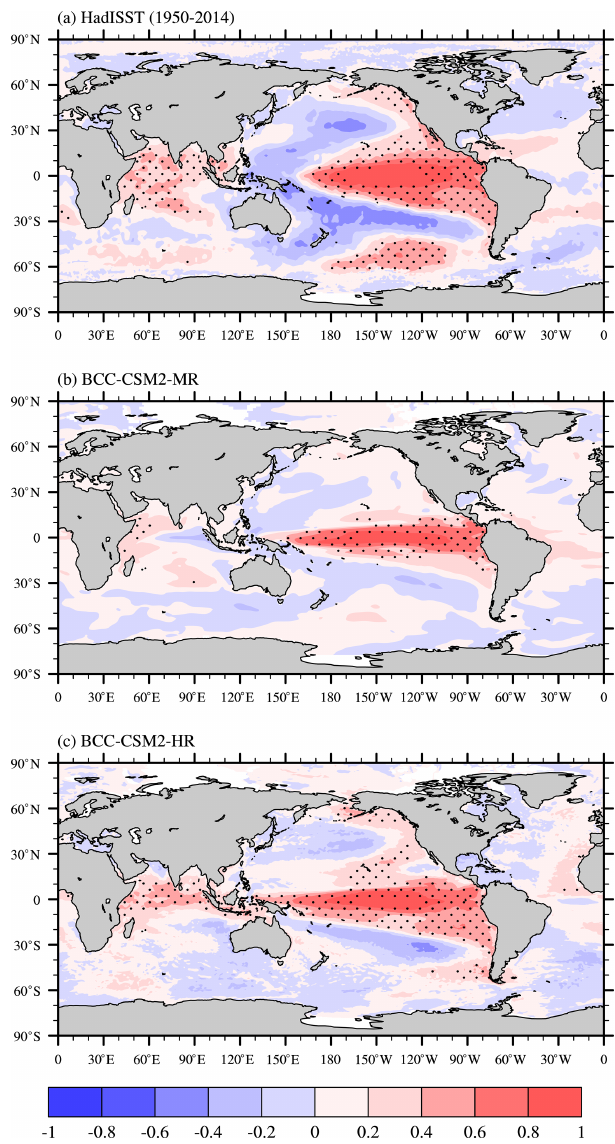
Figure 20. Correlation coefficients between SST and the Niño3.4 index from 1950 to 2014 for (a) HadISST data, (b) BCC-CSM2- MR, and (c) BCC-CSM2-HR. Contour intervals are 0.2. Values sig- nificant at the 99% level using a Student’s t test are